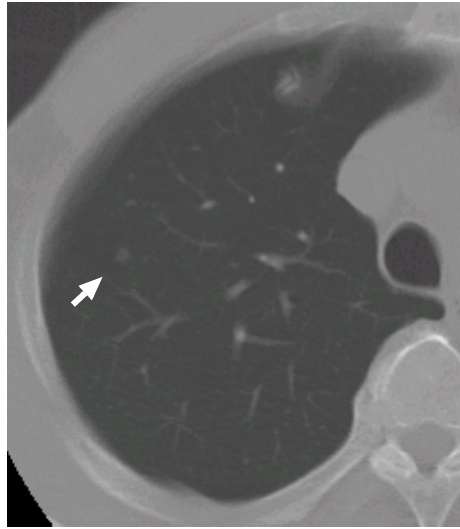
Figure 6. A slice cross section of a sample thoracic CT scan. The arrow indicates a nodule identified by a